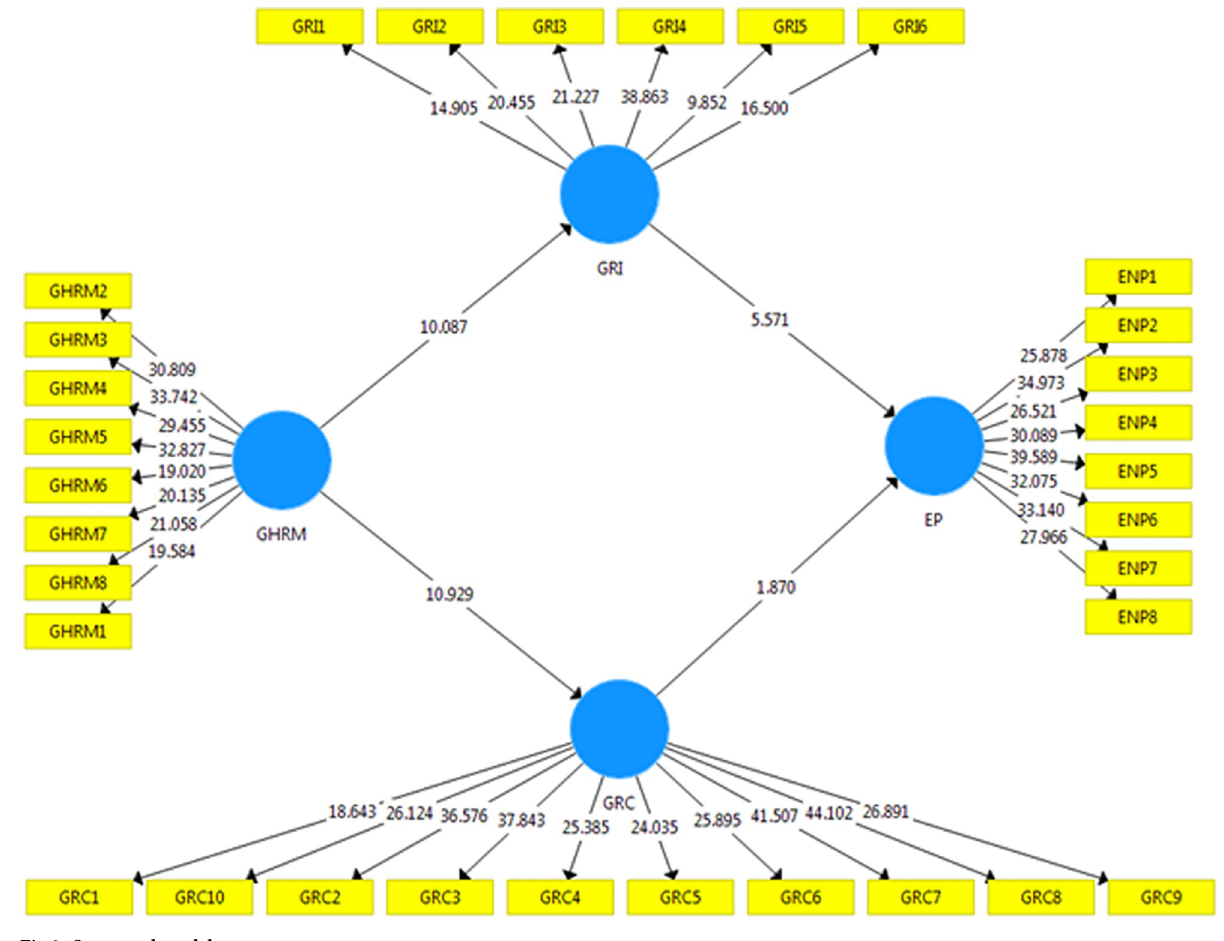
Fig 3. Structural model.